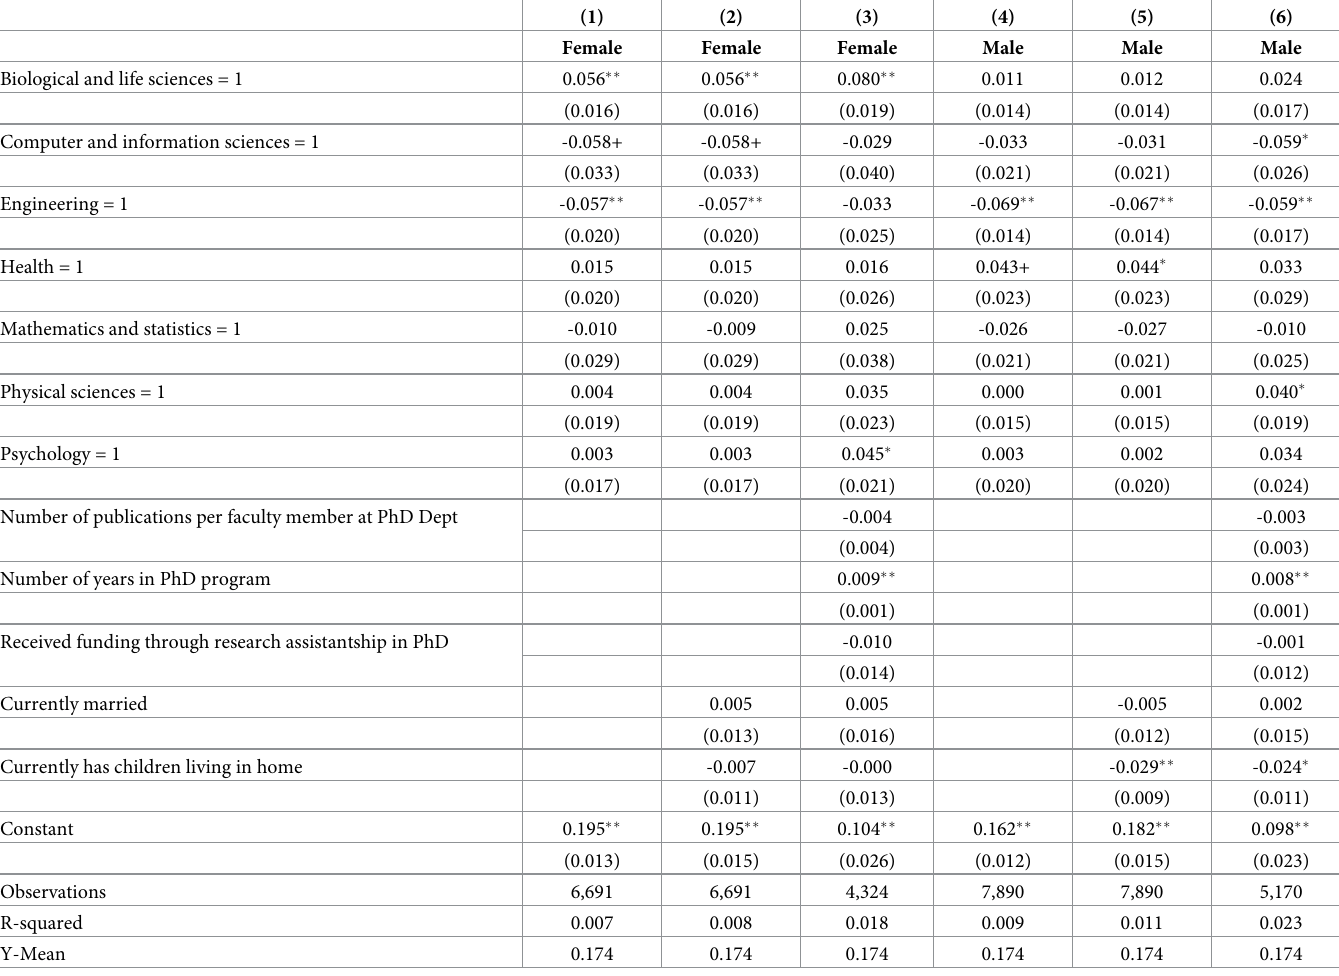
Table 4. Regression exploring factors that may drive participation in NTT jobs, by